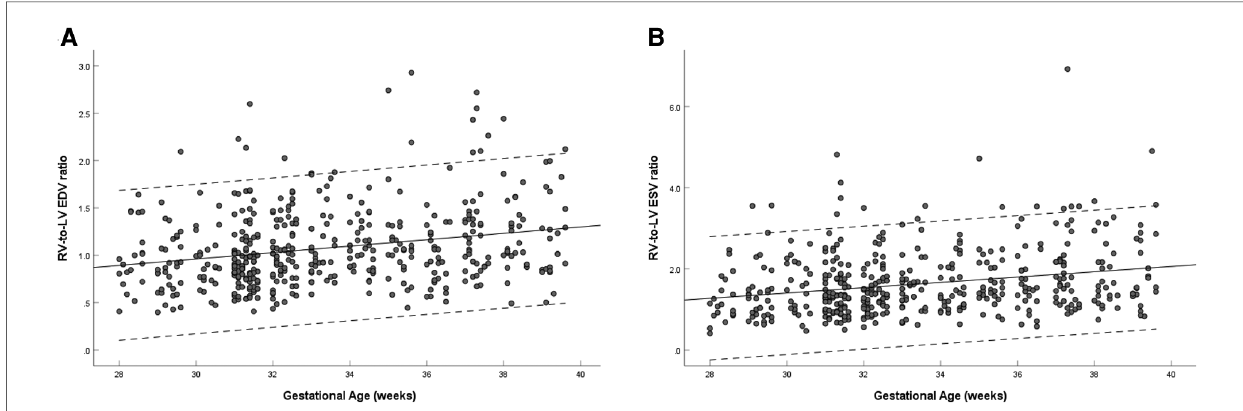
FIGURE 4 Scatterplots of right-to-left ventricular EDV ratio ( A ) and ESV ratio ( B ), according to gestational age (weeks), in 453 low-risk singleton pregnancies from 28 to 39 weeks gestation. Regression lines with the 5% and 95% con fi dence intervals are plotted with the regression equation. LV, left ventricle; RV, right ventricle; EDV, end-diastolic volume; ESV, end-systolic